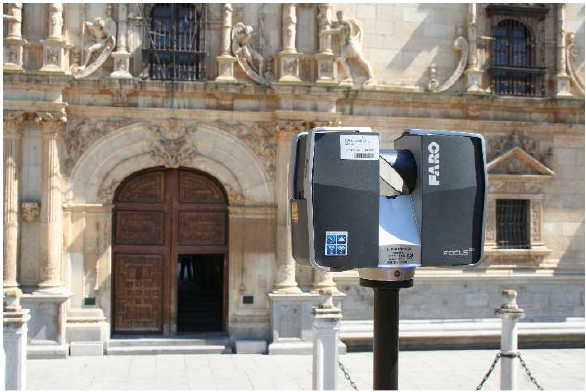
Figure 8: Picture of the laser scanner FARO FOCUS 120 and the San Ildefonso College Facade